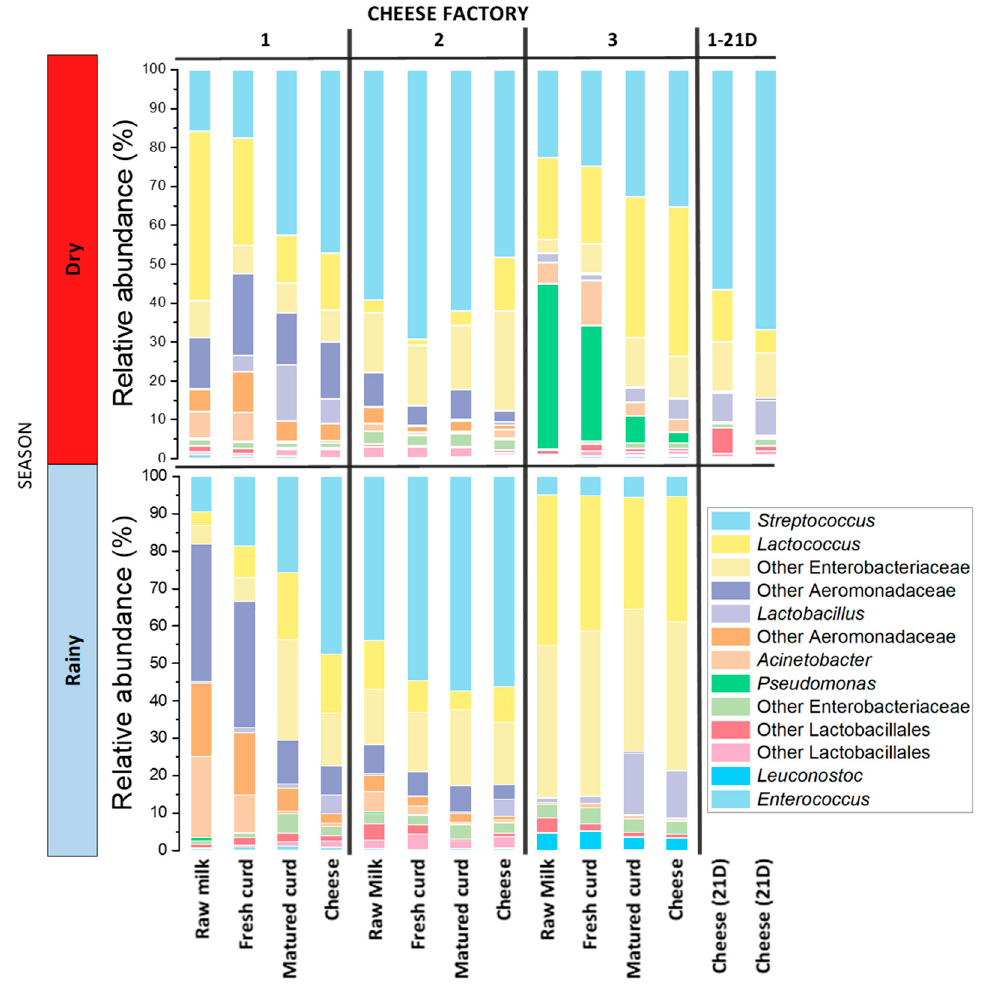
Figure 1. Relative abundance of main bacteria genera conforming artisanal Adobera cheese micro- biota samples at different stages of processing and different sampling seasons. 1–21: Cheese samples from dry season preserved 21 days under refrigeration.